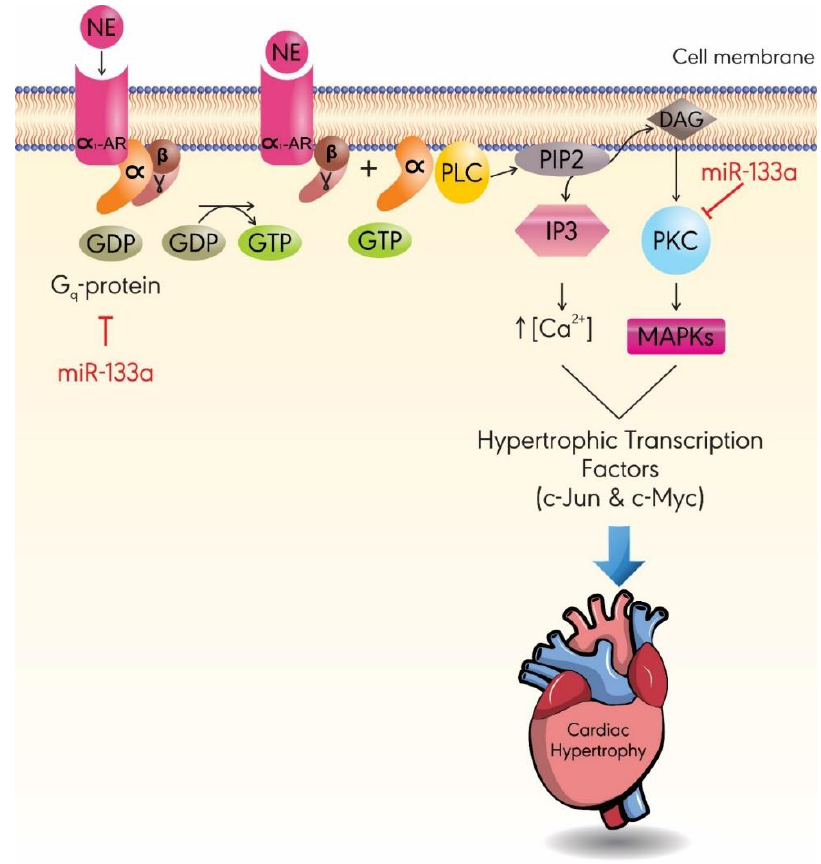
Figure 3. The anti-hypertrophic role of miR-133a is mediated by inhibition of G q -protein and PKC pathways. Norepinephrine (NE) binds to α1 - adrenergic receptor (α1 - AR). Upon its activation, α1 -AR couples to G protein, resulting in the activation of PLC. PLC catalyzes the breakdown of Phosphatidylinositol 4,5-bisphosphate (PIP2) into IP3- and DAG-activating calcium signaling pathways, as well as a PKC – MAPK pathway, respectively. Both pathways increase the expression of hypertrophic transcription factors. DAG: diacylglycerol; GDP: guanosine diphosphate; GTP: guanosine-5 ’ -triphosphate; IP3: inositol 1,4,5-triphosphate; MAPK: mitogen-activated protein kinase; PKC: protein kinase C; PLC: phospholipase C.